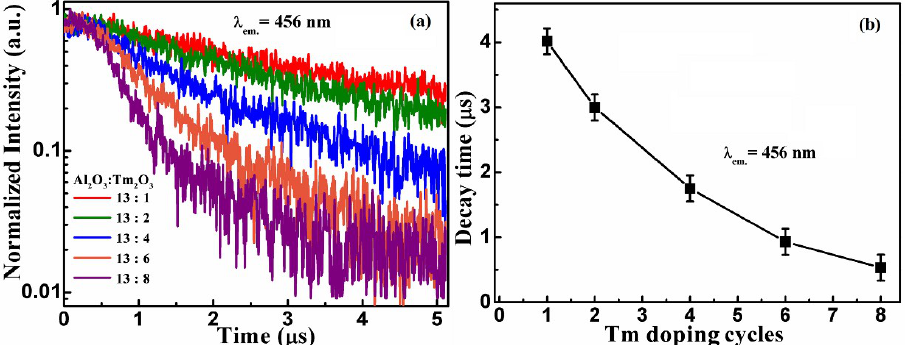
Figure 5. ( a ) The EL decay lifetime of the 456 nm EL from different nanolaminate Al 2 O 3 /Tm 2 O